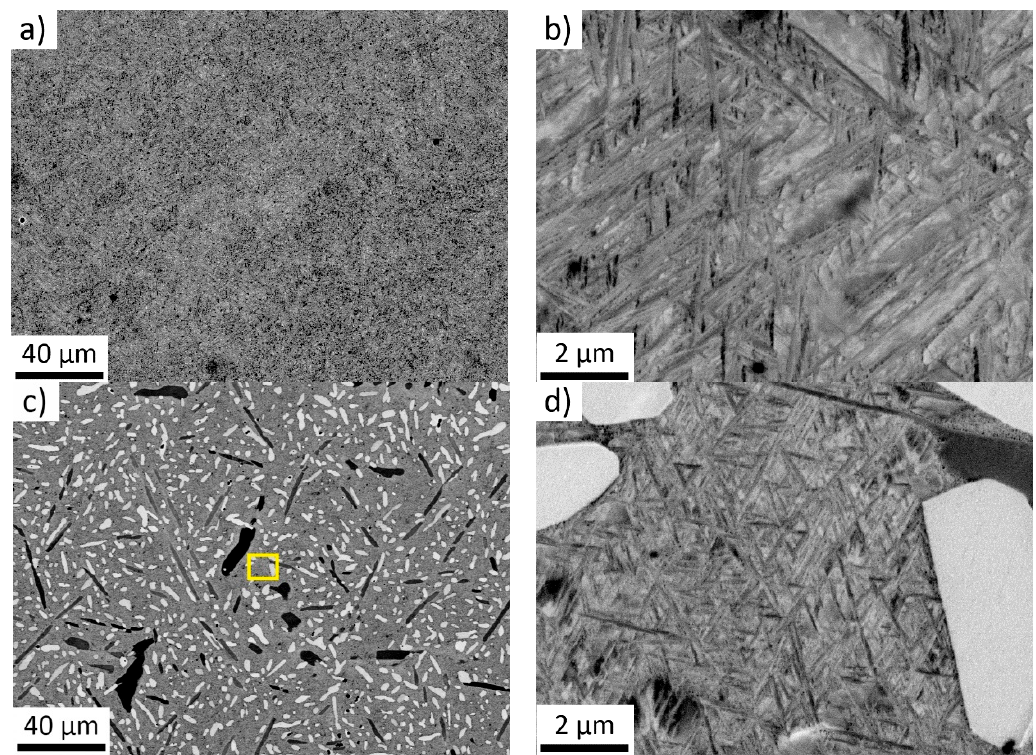
Figure 2. SEM of beta-annealed alloys: ( a ) Zr-4Sn-4Nb alloy—an overview; ( b ) Zr-4Sn-4Nb—detail of lamellar α ’ martensite, ( c ) Zr-8Sn-4Nb—an overview; position of the detail in ( d ) is marked by yellow rectangle, ( d ) Zr-8Sn-4Nb—detail of lamellar α ’ martensite and bright Zr 4 Sn particles.